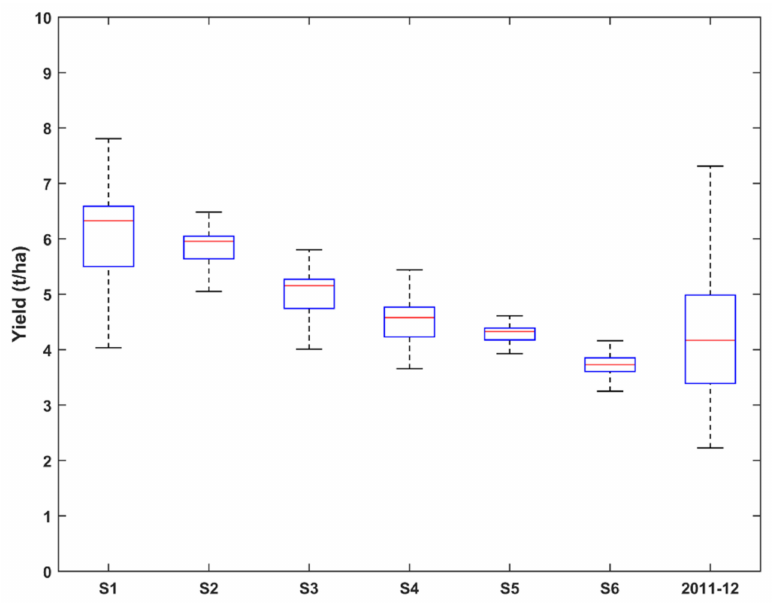
Figure 14. Variation of grain yield (t/ha), between simulated scenarios and the real case (2011–2012 agricultural season) based on the AquaCrop model (second approach). The statistical Student’s t -test shows that S1 and S2 are identical ( p > 0.05), and the other scenarios are significantly different ( p ≤ 0.05).